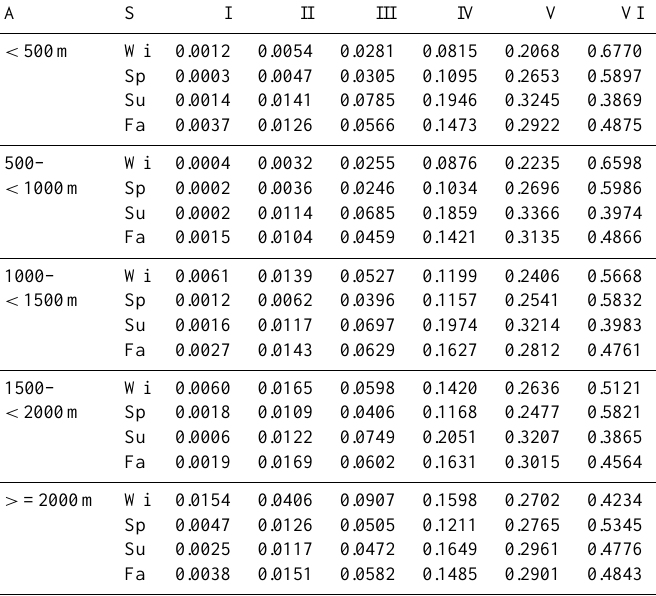
Table D3. Probabilities of cloud coverage classes for a 24h precipitation sum of > 0–4cm depending on explanatory variables following selected Swiss climate stations. For further description see Table